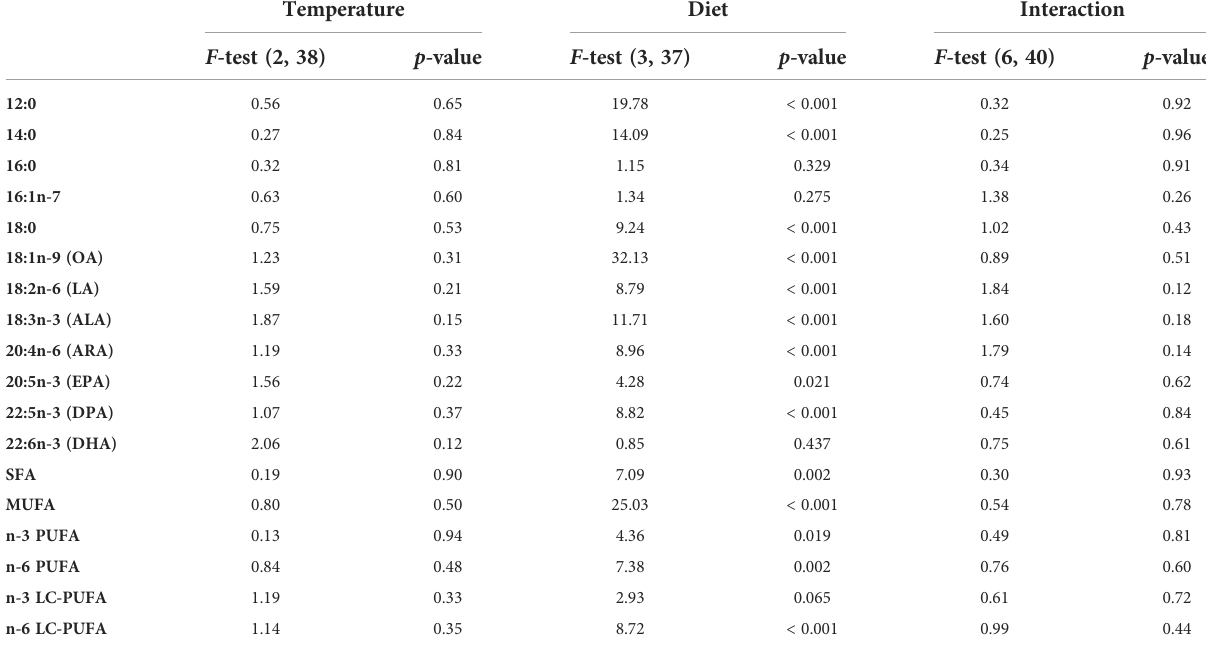
TABLE 4 Two-way ANOVA results of the fatty acid composition of samples of G. locusta fed different diets at four temperatures. Temperature Diet Interaction